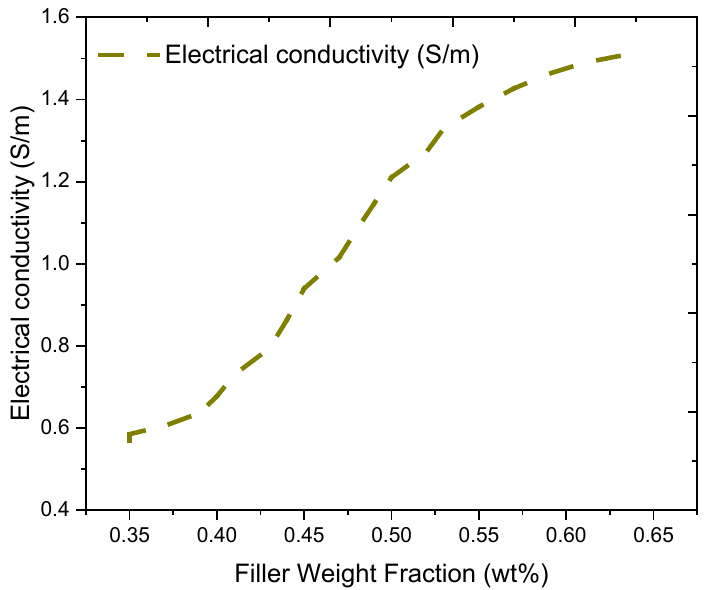
Figure 2. Electrical conductivity measurement of PVA/PPy/rGO nanocomposites. Experimental Data and Modeling Analysis